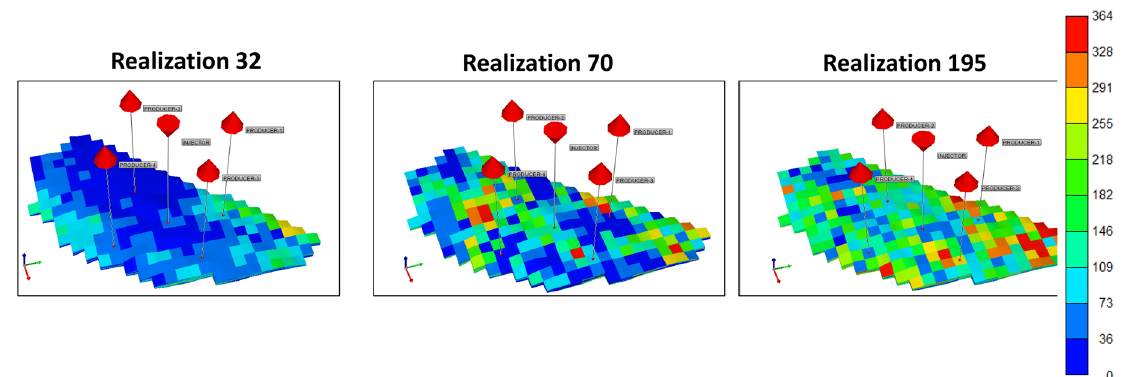
Fig. 20 Three different geological realizations selected for further analysis